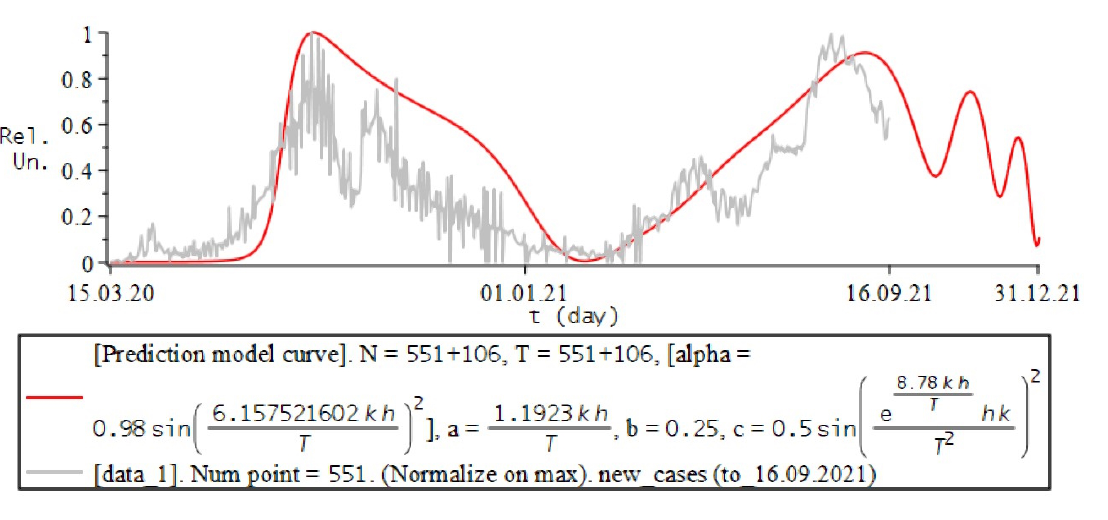
Figure 5. Visualization